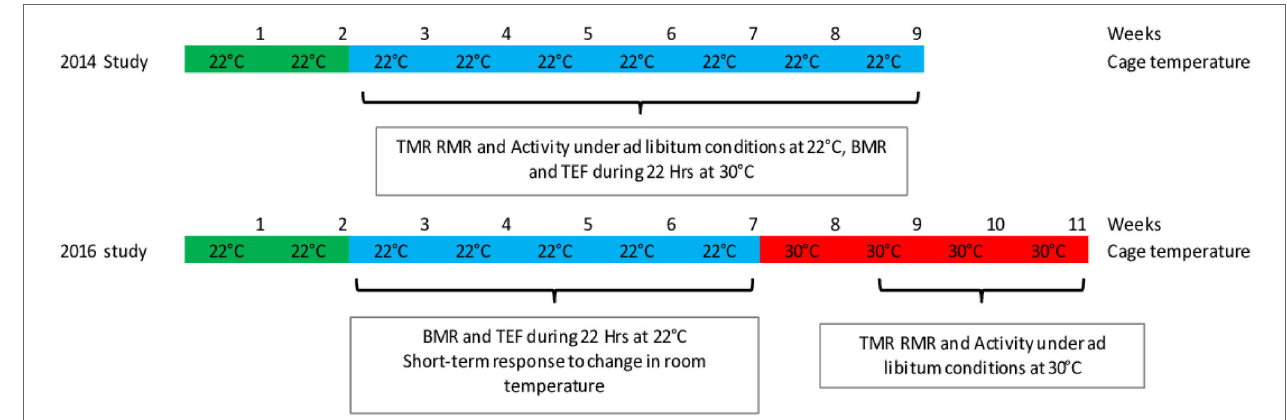
FigUre 1 | experimental design of the two studies